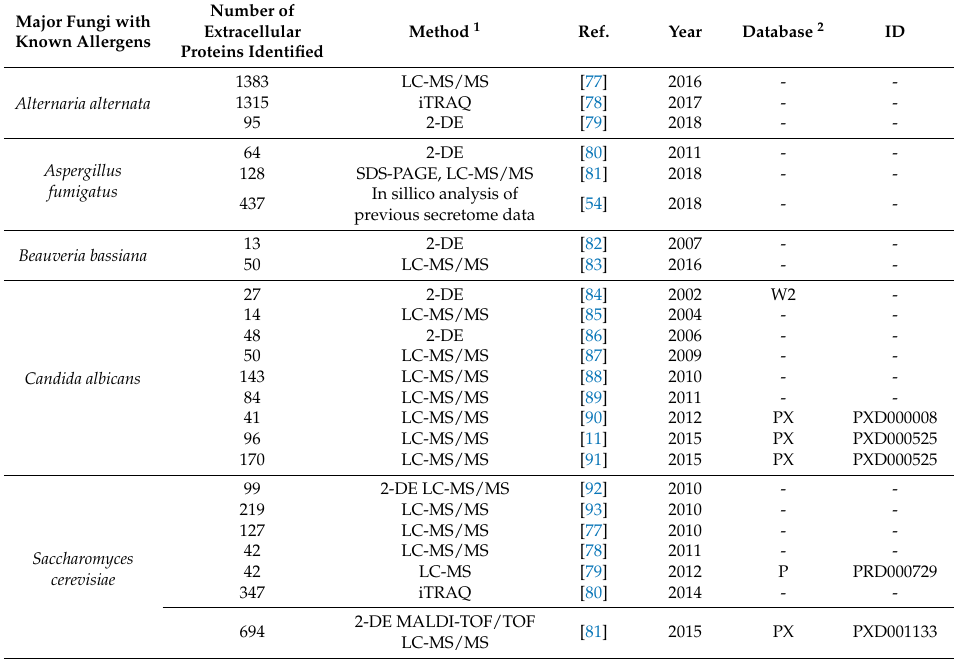
Table 1. Recent proteome data of extracellular proteins in some allergenic and/or pathogenic fungi. Major Fungi with Known Allergens